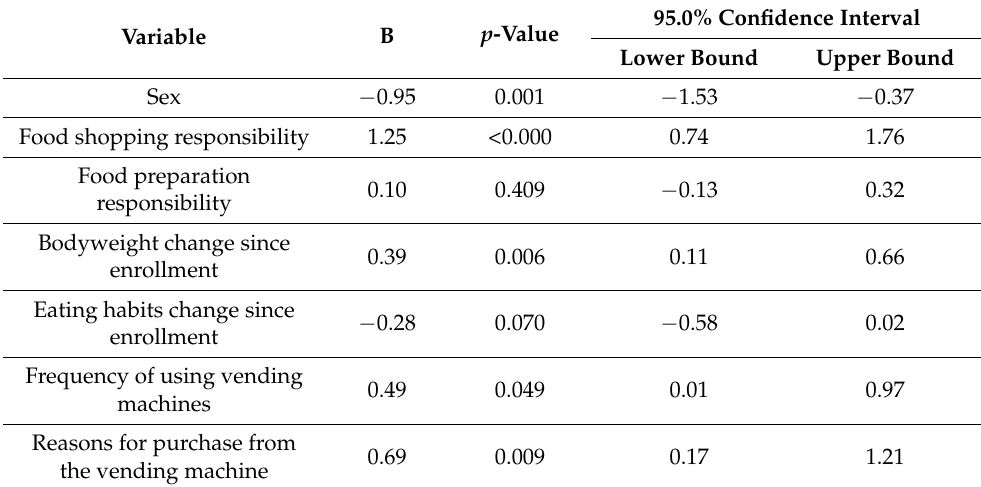
Table 5. Linear regression analysis using the likeliness of purchasing healthier options as a dependent